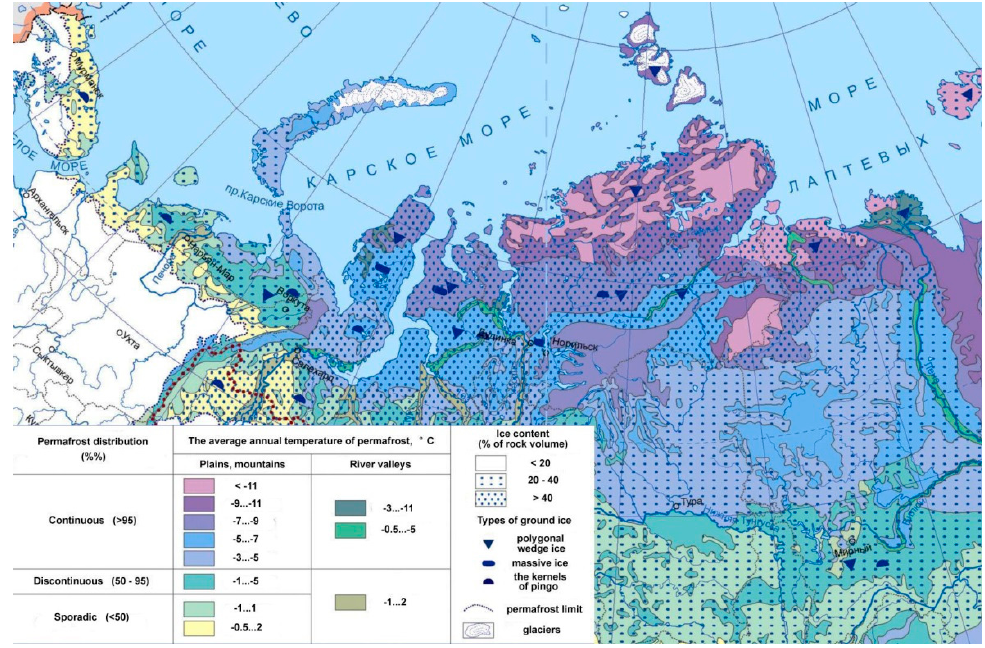
Figure 7. Map fragment the permafrost of Russia, scale 1:20,000,000.